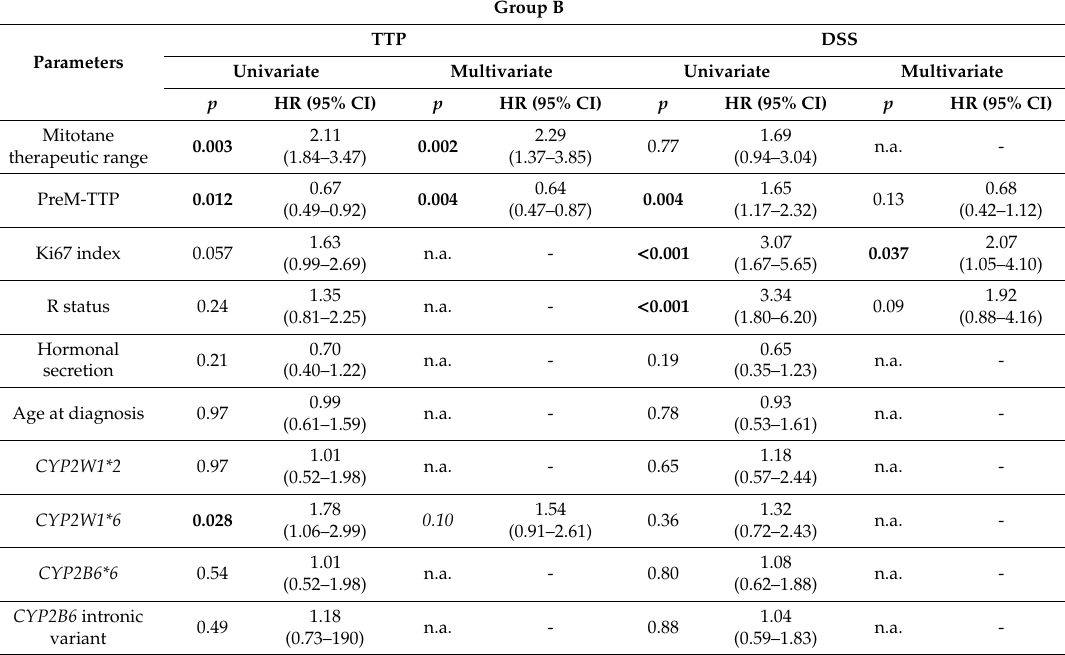
Table 4. Univariate and multivariate analysis correlating clinical and histopathological parameters and the investigated SNPs with the response to mitotane treatment and the disease-specific survival in group B ( n =